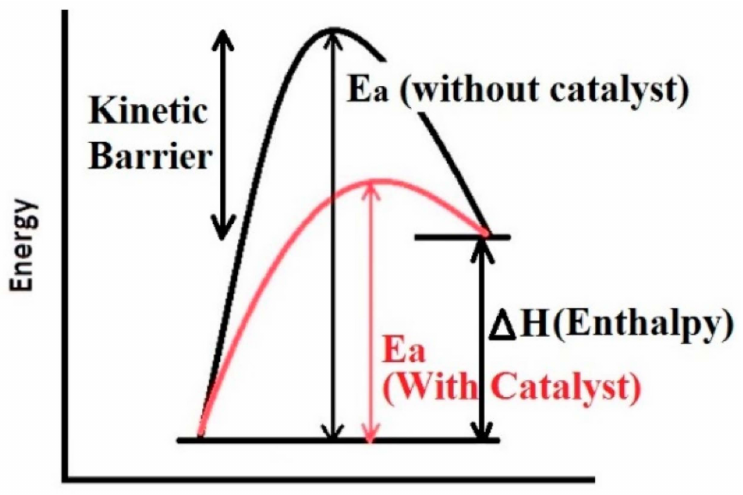
Figure 8. Representation of the kinetic barrier of the reaction and lowering the activation energy (Ea) using catalyst